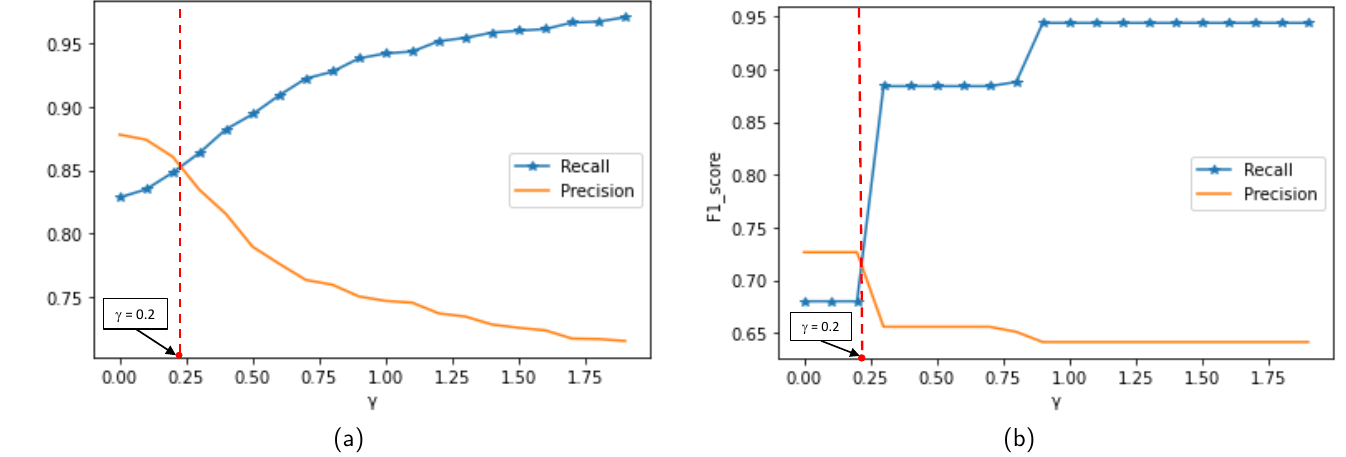
Figure 8. Selecting γ value based on algorithm performance when detecting noise: ( a ) MIT Badge dataset. ( b ) sCREEN